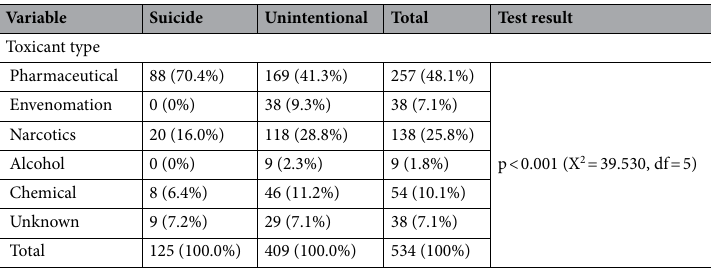
Table 4. Comparison of toxicant type by cause of poisoning.